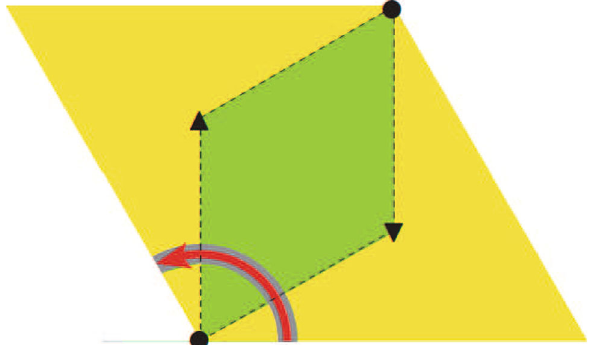
Fig. 3 The flux (cid:10) F ij (cid:11) at a fixed point